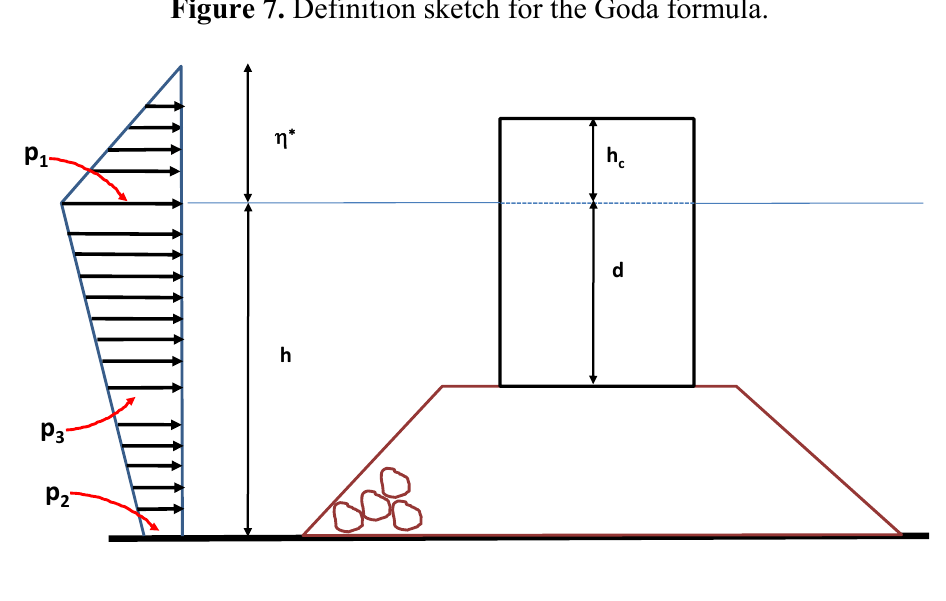
Figure 7. Definition sketch for the Goda